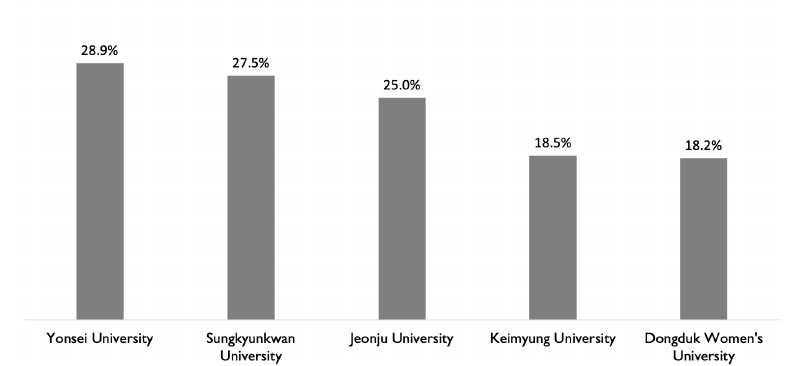
Figure 3. Top 5 universities with high frequencies of information-technology-related